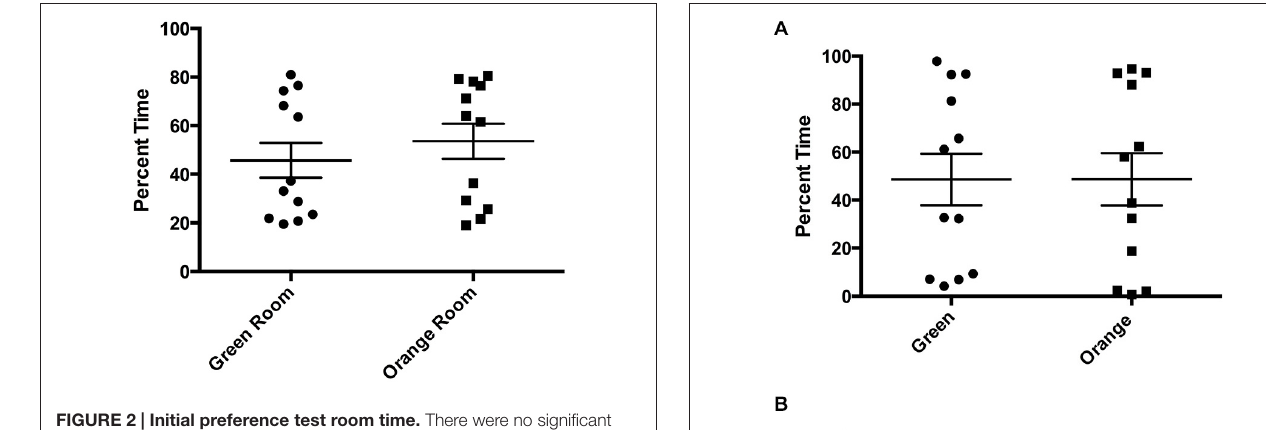
FIGURE 2 | Initial preference test room time. There were no significant differences in percent time spent in each room during the initial preference test ( p > 0.05). Individual data points are plotted with the Mean ± SEM.